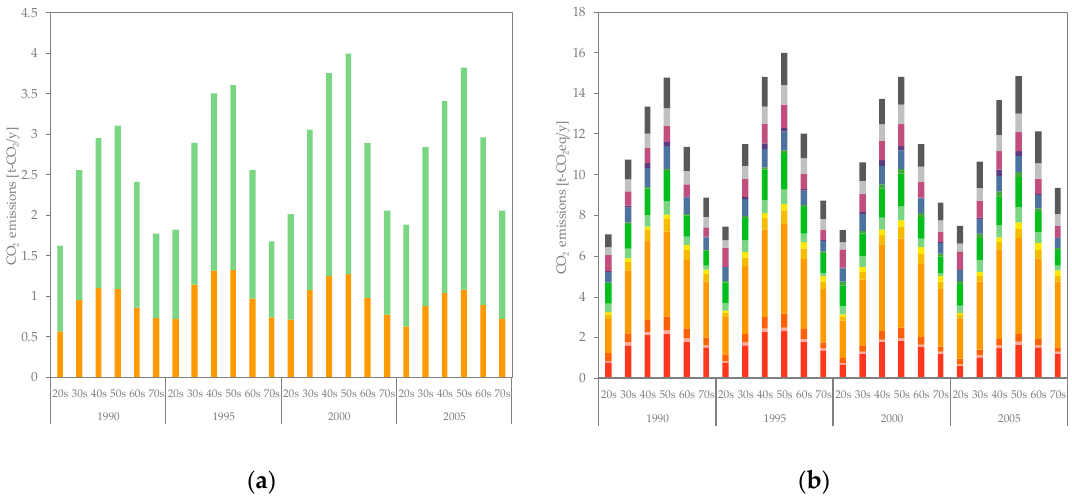
Figure A1. Sectoral composition of per household CO 2 emissions by age group (t-CO 2 /y) from 1990 to 2005. ( a ) Direct and ( b ) indirect.